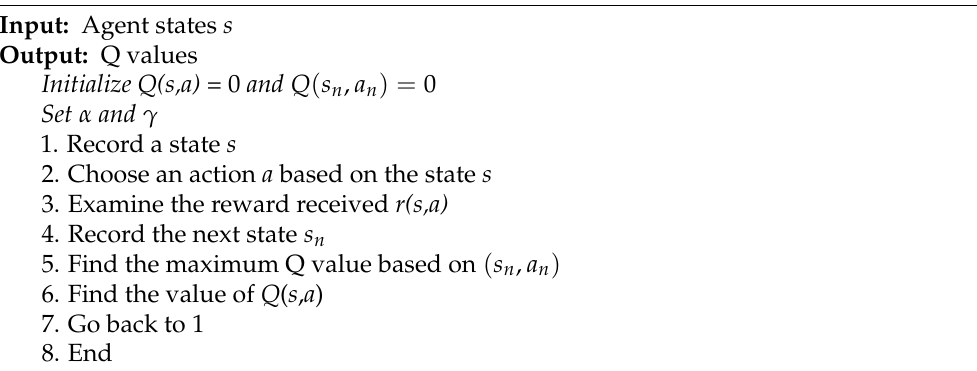
Algorithm 1 Q-learning general algorithm for operation